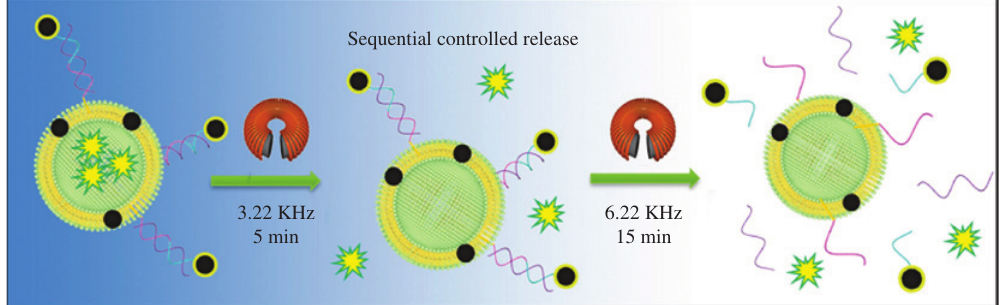
Figure 12: Schematic illustration of sequential controlled release of dual MNP-equipped liposomes. Reprinted with permission from Ref. [182], copyright 2016, American Chemical